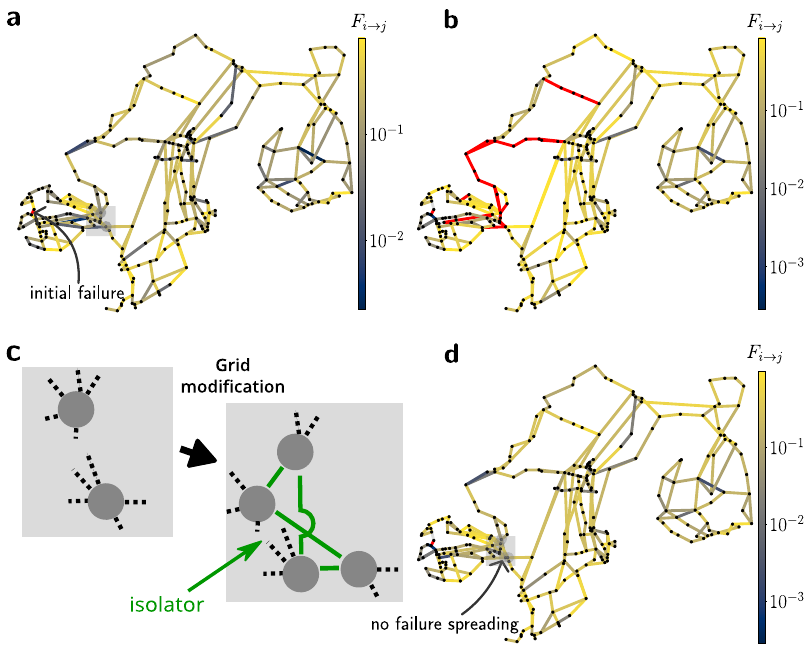
Fig. 4 Network isolators can contain cascading failures in power grids. a Line loading (colour code) on the Scandinavian grid in units relative to maximal loading before the initial failure of a single line (coloured red). b The initial failure results in a cascade of overloads (red coloured lines) until the grid disconnects into several parts. c Magni fi cation of the grid structure in Eastern Norway (grey box, a ). A small modi fi cation of the grid enables the construction of a network isolator: adopting the recipe presented in Fig. 3a, we select two nodes (left) that are further split up into two separate nodes each which are mutually connected via a network isolator by adding four edges (right, green). Note that the removal of these two nodes would disconnect the network into two separate parts, i.e. they form a vertex cut of size two. d Introducing the network isolator completely suppresses the spreading of failures from Western Norway to the rest of the grid thus inhibiting the cascade observed in ( b ). The fi rst two steps of this cascade are shown in Supplementary Fig.